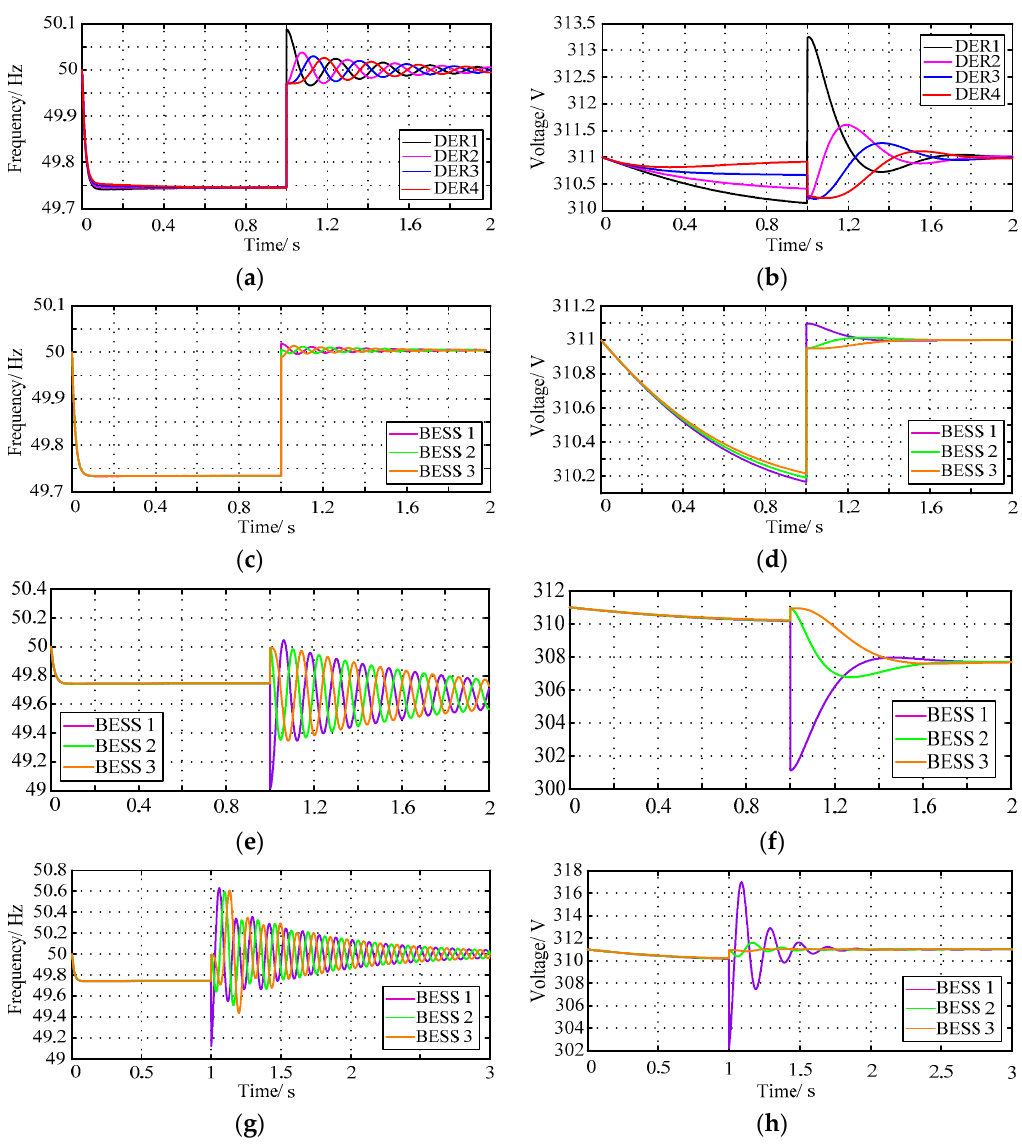
Figure 10. Voltage and frequency variations considering the line impedance, corresponding to the BESSs and loads; ( a ) The frequency variations of PVs considering the line impedance of BESSs and loads; ( b ) The voltage variations of PVs considering the line impedance of BESSs and loads; ( c ) The frequency variations of BESSs under the situation 1; ( d ) The voltage variations of BESSs under Situation 1; ( e ) The frequency variations of BESSs under Situation 2; ( f ) The voltage variations of BESSs under the situation 2; ( g ) The frequency variations of BESSs under Situation 3; ( h ) The voltage variations of BESSs under Situation